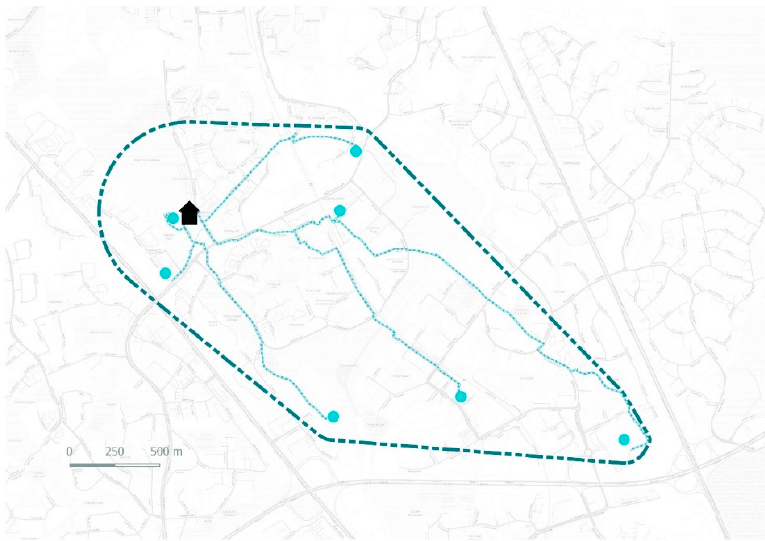
Figure 2. An example of an individual home range and active travel routes of a respondent.